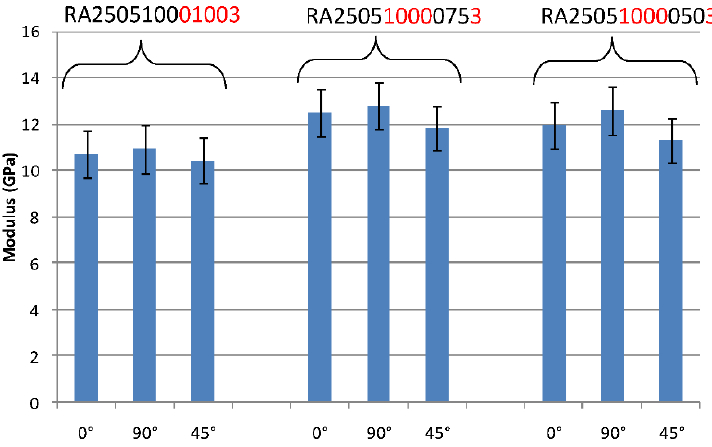
Figure 7. Average tensile modulus for different orientations of the specimens .